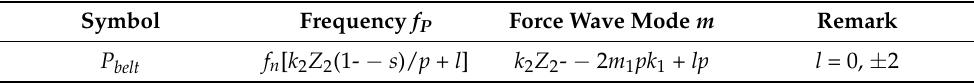
Table 2. Characteristics of phase belt force wave P belt .